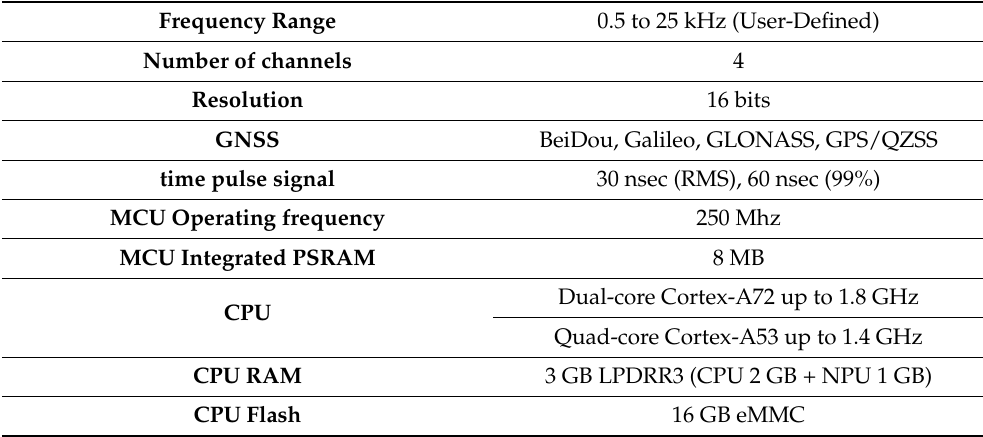
Table 1. ESTHISIS Platform Technical Specifications.